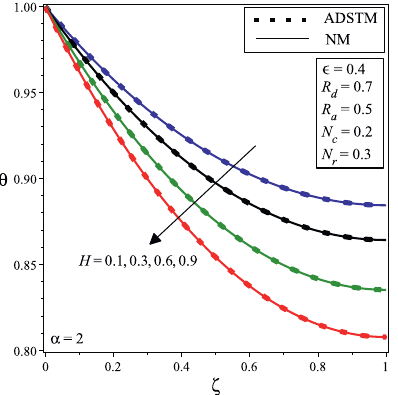
Fig. 5: Effect of Hartman parameters, H and comparison between the ADSTM with the numerical solution for classical order α =